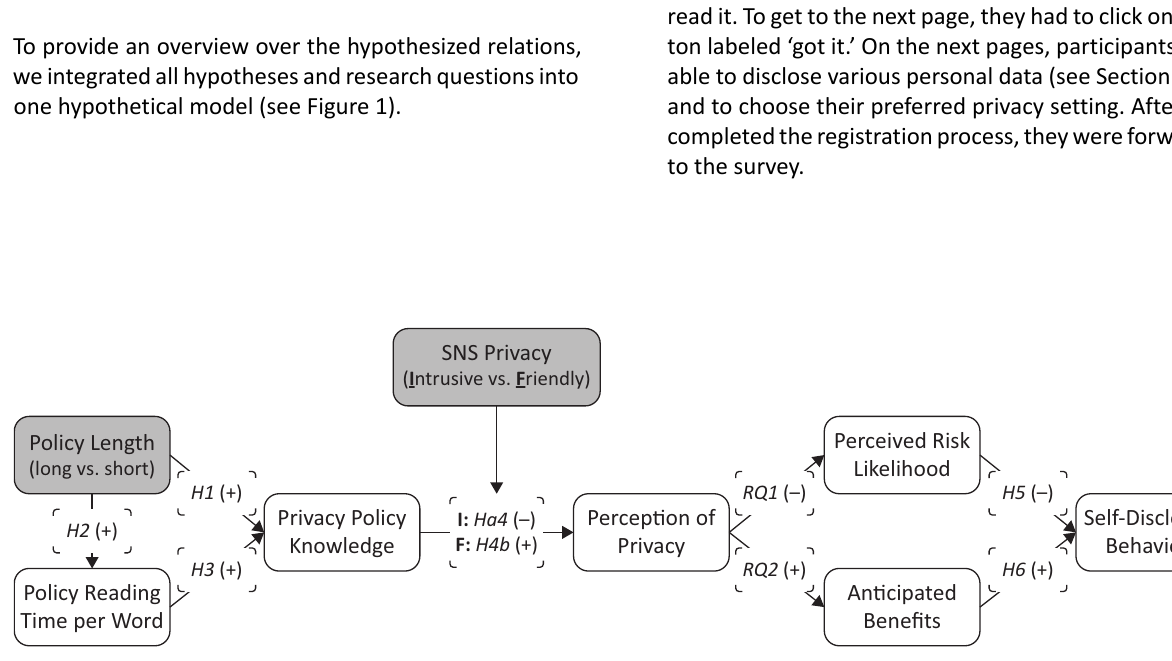
Figure 1. The integrative model including all hypotheses and research